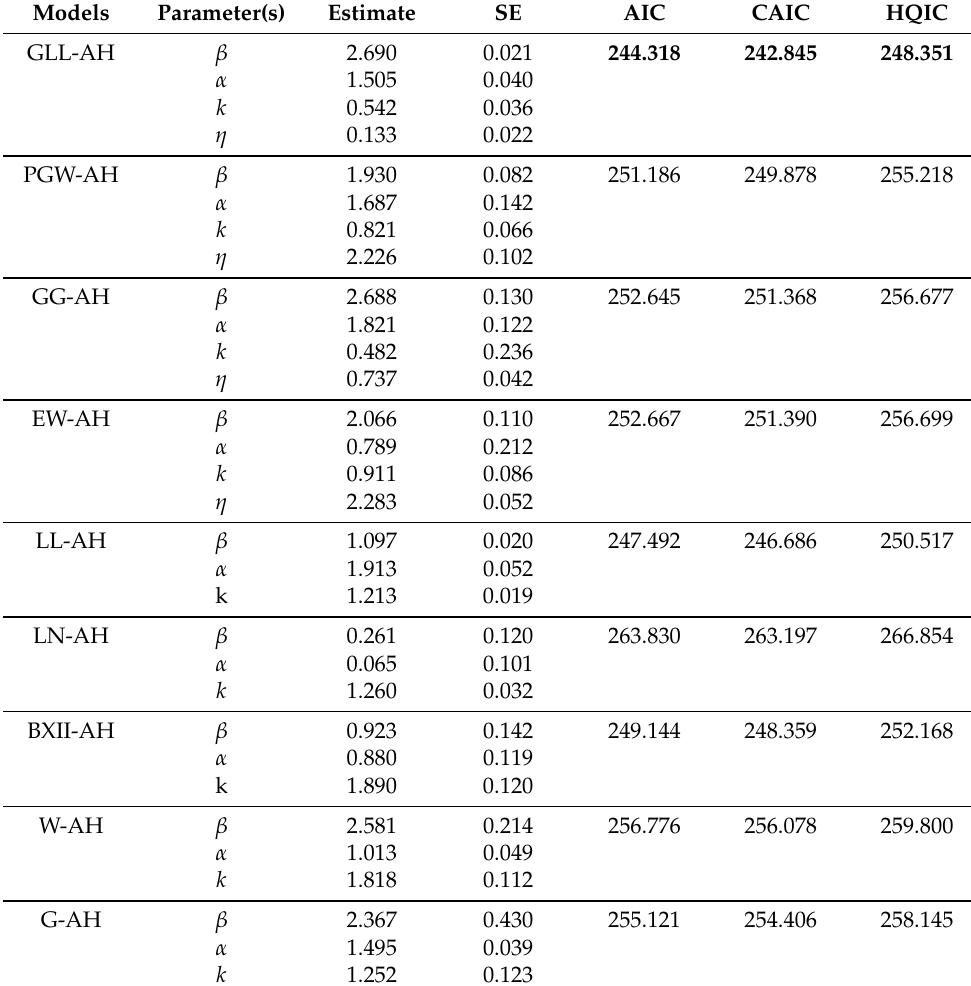
Table 3. Results from the fitted proposed fully parametric AH regression model with different baseline distributions to gastric cancer